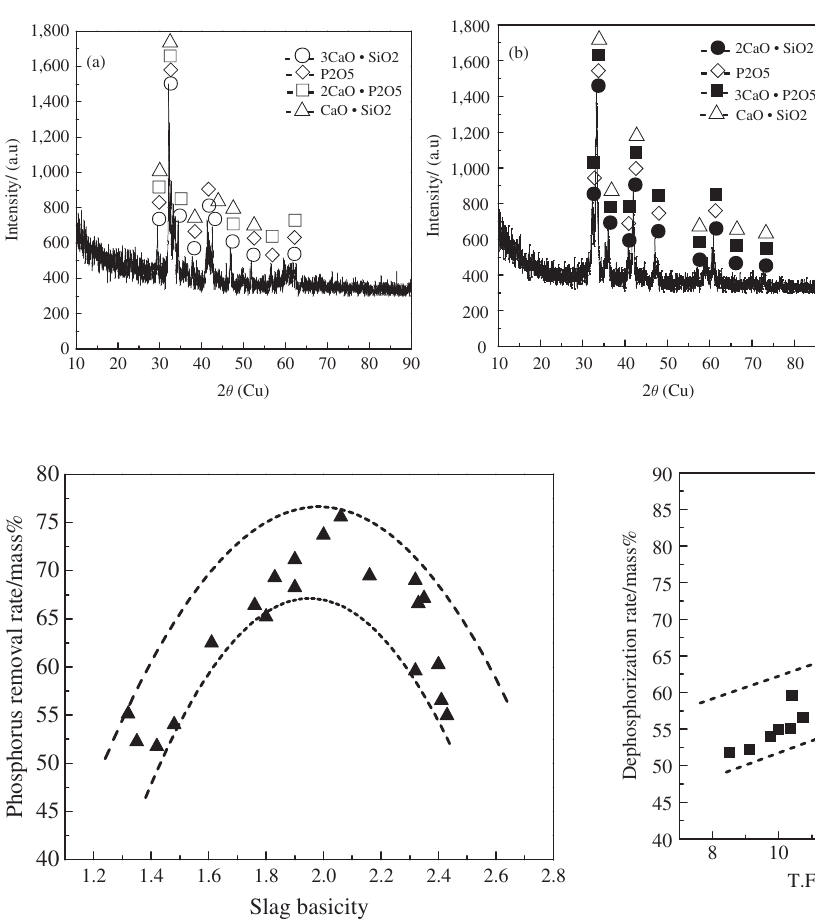
Figure 9: Effect of the total iron content in slag on dephosphoriza- tion rate at the first